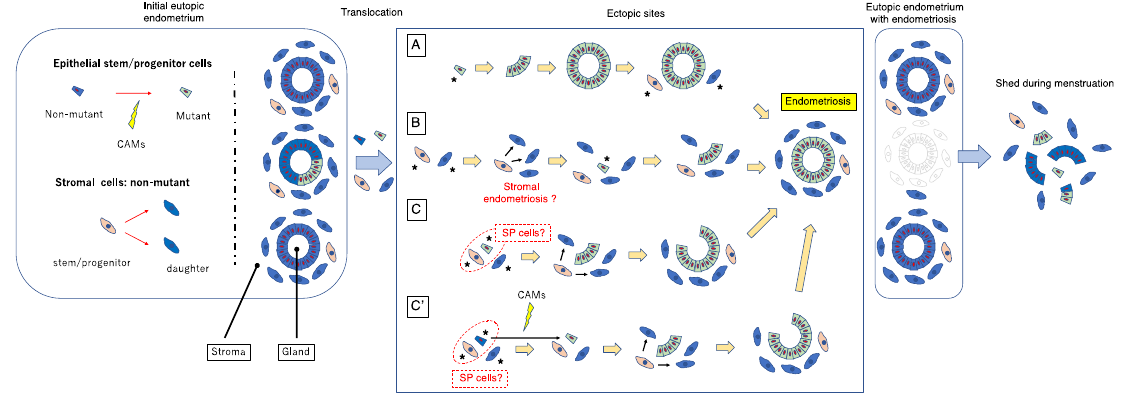
Figure 5. A revised stem cell theory that proposes a cellular model for the pathogenesis of endometriosis. Blue and yellow green quadrangles represent endometrial epithelial stem/progenitor cells without or with CAMs, respectively. Light orange and blue snap pea-like shapes represent endometrial stromal stem/progenitor cells and their daughter cells. Red arrows indicate the progressive generation from the left to right. The asterisks indicate endometrial cells that are derived from eutopic endometrium and implanted ectopically via retrograde menstruation and/or vascular lymphatic dissemination. The detailed explanation of this figure is provided in the text. SP, side population; CAMs, cancer-associated muta- tions.